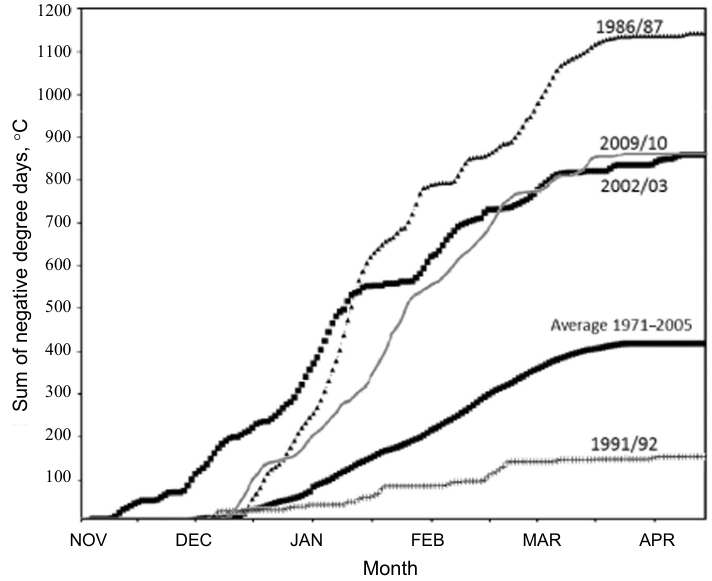
Fig. 3. The sum of negative degree days in the central Gulf of Finland. A very severe winter (1986/87), a mild winter (1991/92), a severe winter (2002/03), the winter of 2009/2010 and the average for the winters of 1971(cid:150)2005 are shown.